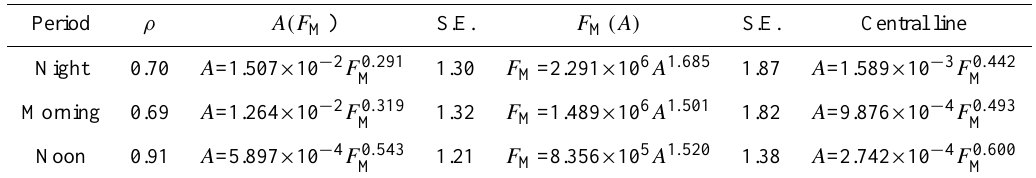
Table 5. Regression analysis for the three periods of the day, in terms of F M .